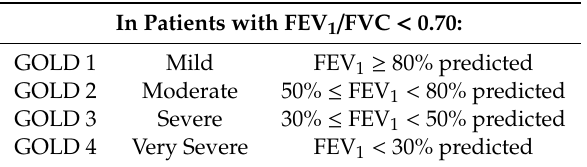
Table 2. Classification of airflow limitation severity in chronic obstructive pulmonary disease (COPD). In Patients with FEV 1 / FVC <